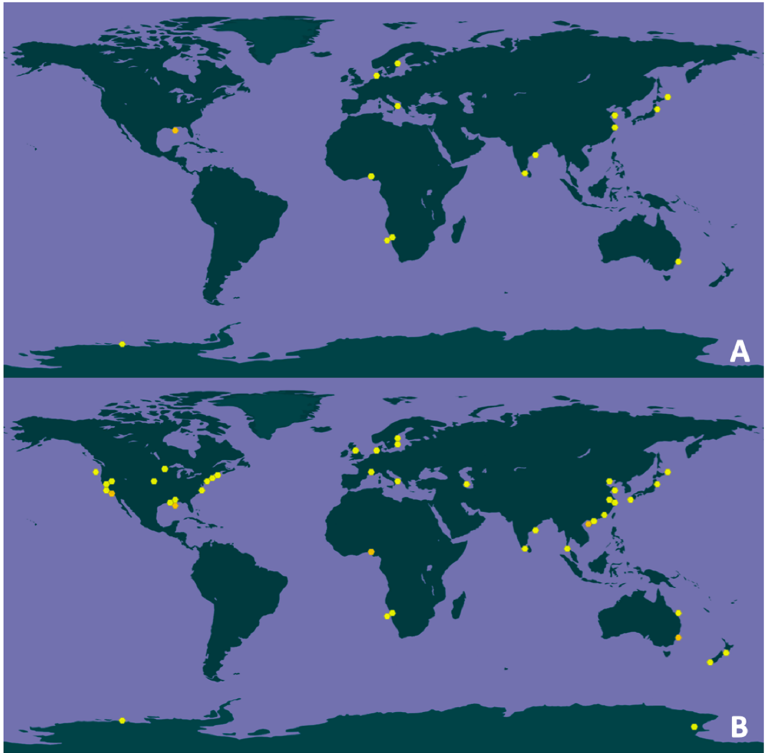
Figure 2. ( A ) Location of the 25 georeferenced records (among the total 35 occurrences) for the genus Dissulfurirhabdus in June 2020 based on the metagenomic 16S ribosomal RNA gene sequences from the GBIF database; ( B ) Location of the 114 georeferenced records (among the total 200 occurrences) for the genus Dissulfurirhabdus in June 2020 based on the metagenomic and metabarcoding 16S rRNA sequences from the GBIF database.